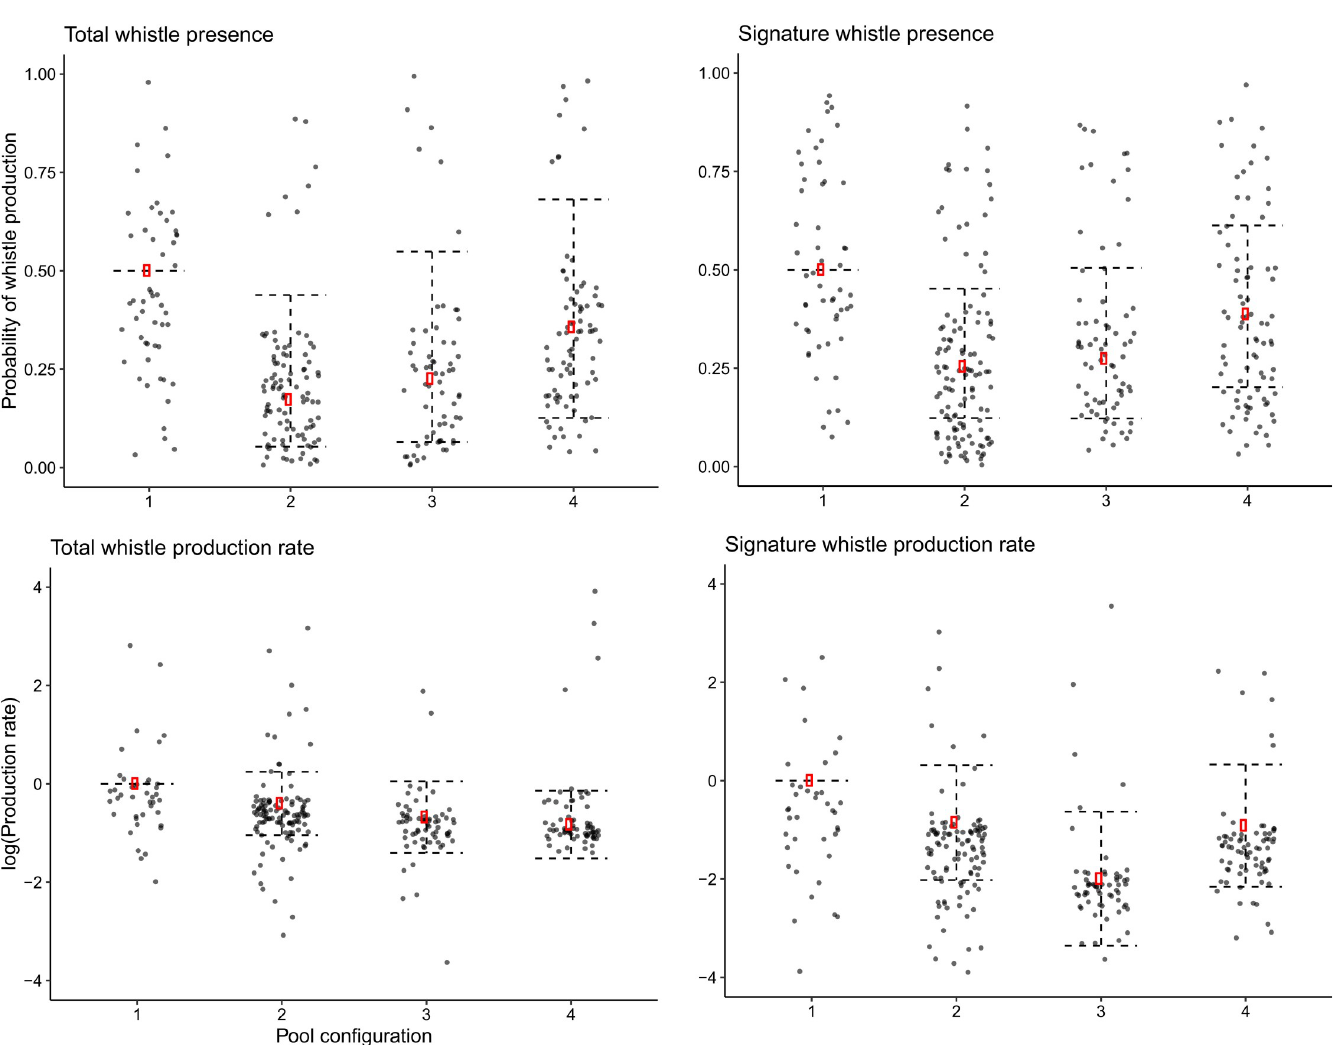
PLOS ONE | https://doi.org/10.1371/journal.pone.0250913 September 1,